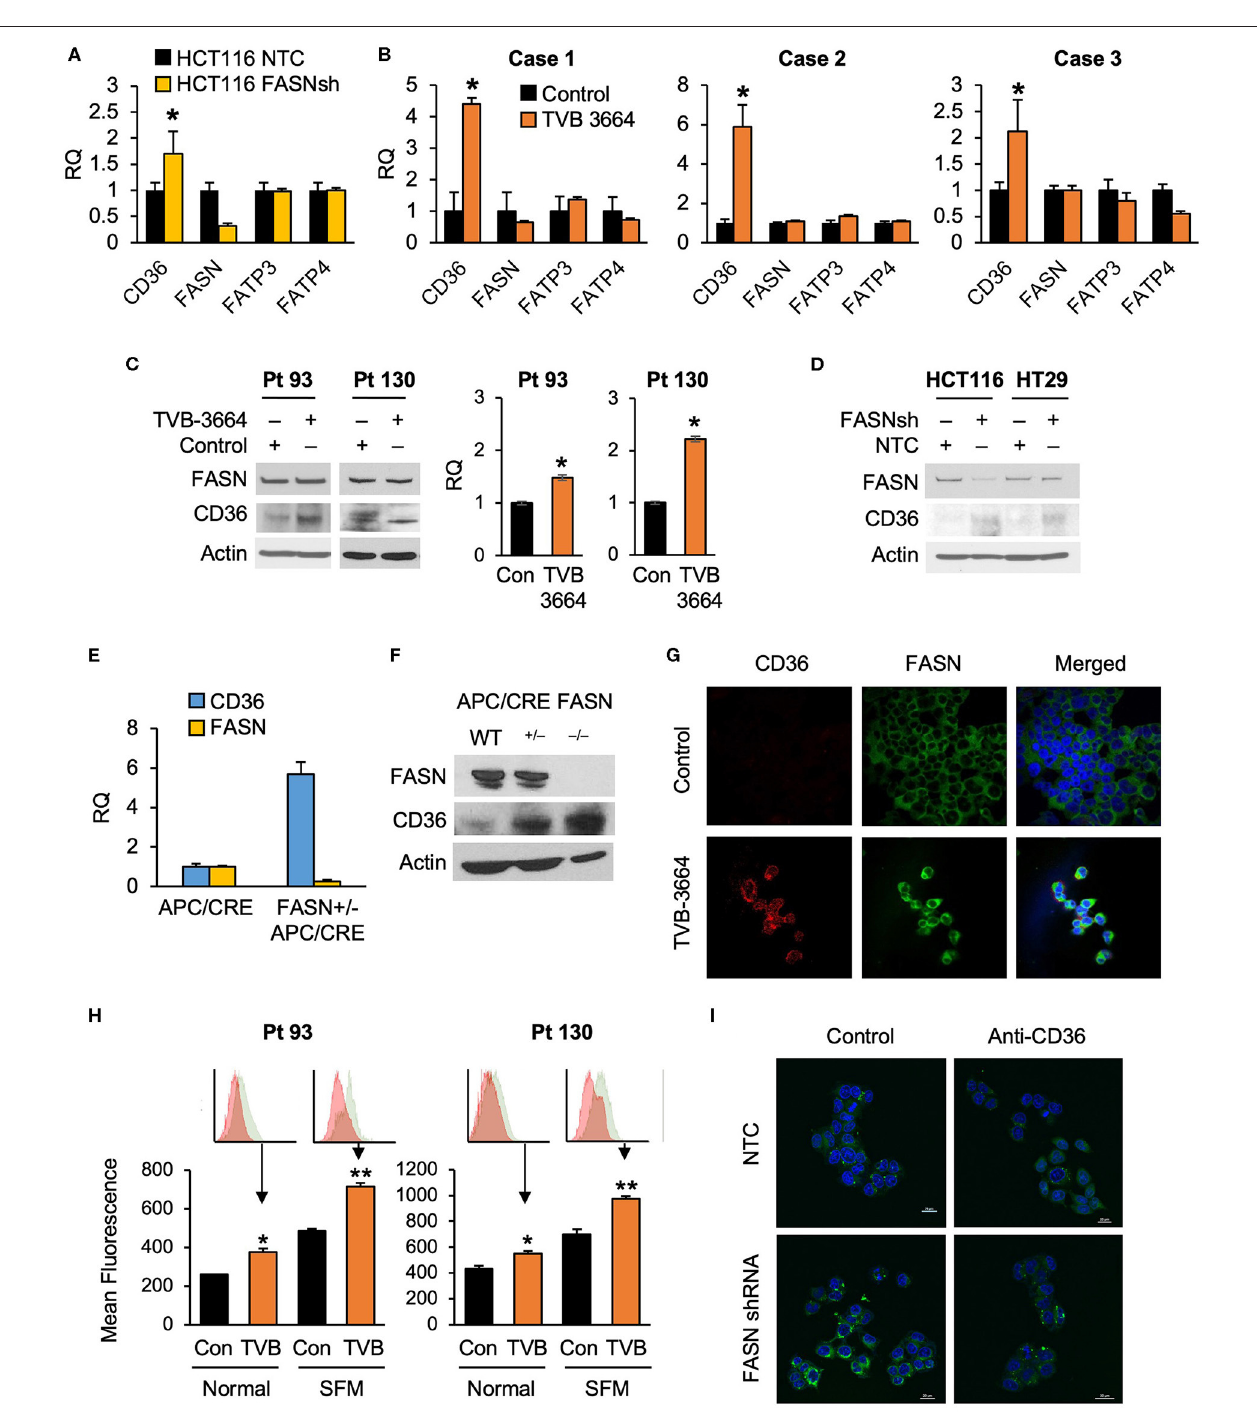
FIGURE 2 | Expression of CD36 is selectively regulated by the level of de novo fatty acid synthesis in CRC. (A) shRNA-mediated knockdown of FASN leads to upregulation of CD36 mRNA expression in HCT116 cells (* p < 0.05). (B) TVB-3664 treatment of CRC tissue slices (18h) selectively upregulates CD36 mRNA expression (* p < 0.05). (C) TVB-3664 treatment of Pt 93 and Pt 130 primary CRC cells increases CD36 mRNA and protein expression. (D) shRNA mediated knockdown of FASN increases CD36 protein expression in HCT116 and HT29 cells. (E) Relative mRNA expression of FASN and CD36 in intestinal tumors collected from APC/Cre and FASN + / − /APC/Cre mice. (F) FASN and CD36 protein expression in intestinal mucosa collected from Apc/Cre and Apc/Cre mice with hetero- and homo-zygous deletion of FASN. (G,H) Inhibition of FASN increases membrane-associated expression of CD36. (G) Confocal images of FASN and CD36 in control and 0.2 µ M TVB-3664 treated (6 days) Pt 93 primary CRC cells. (H) Flow cytometry analysis of Pt 93 and Pt 130 primary CRC cells treated with 0.2 µ M TVB-3664 (6 days) in normal and serum free media conditions. Mean fluorescence for CD36 is shown for representative data from three different experiments (** p < 0.01, * p < 0.05). (I) FA uptake in HCT116, NTC, and FASN shRNA. Cells were pre-treated with anti-CD36 antibody or vehicle for 24h and then treated with BODIPY FL for 10min.